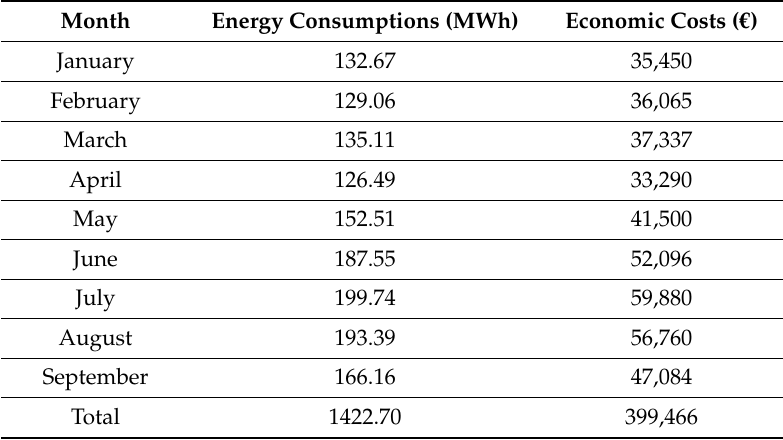
Table 9. ASI electricity consumption and related economic costs.